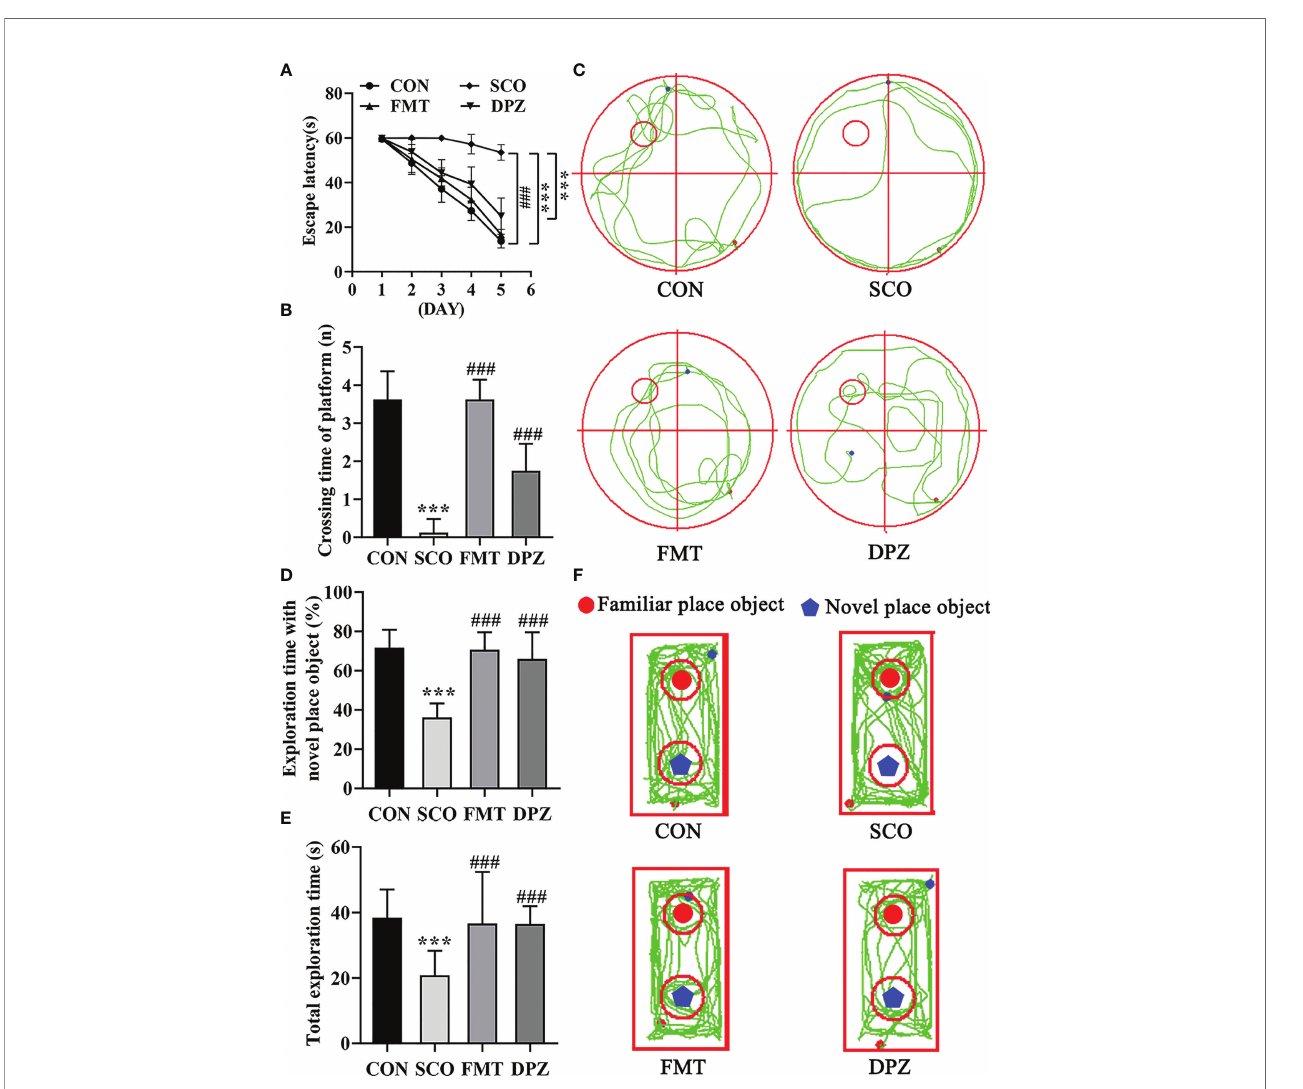
FIGURE 7 | Evaluation of spatial learning and memory performance of the CON, SCO, FMT and DPZ groups using the Morris water maze test and novel object recognition (n=8-10). For (A – C) MWM test analysis, we see the following: (A) the escape latency time to reach the hidden platform during training days; (B) the number of entries in the platform zone during the probe trial; and (C) the representative track plots of 4 groups. For D-F NOR analysis, we see the following: (D) the percentage of time spent with the object in the novel place to total object exploration time; (E) the total object exploration time; and (F) the representative track plots of the 4 groups: ** p < 0.01, ***p < 0.001 vs. CON, ## p < 0.01, ### p < 0.001 vs.